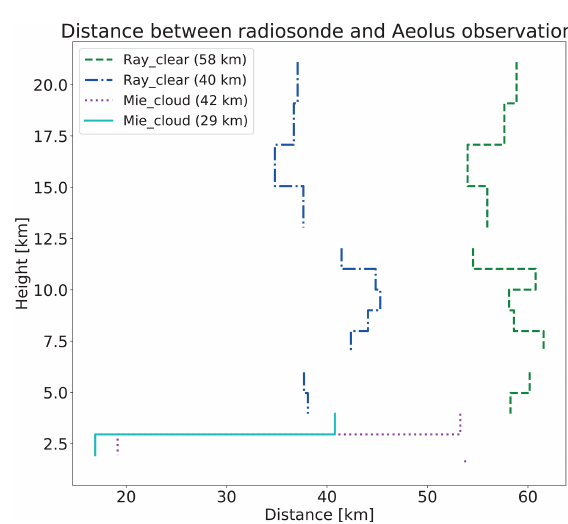
Figure 3. The distance between the radiosonde and the geolocation of the single wind observations for the two closest Mie cloudy (ma- genta and cyan) and Rayleigh clear (green and blue)